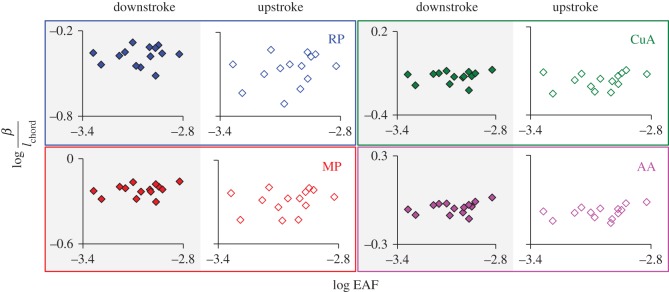
Logarithmic relationship between chord-length-specific deflection (β/lchord) at the trailing edge and the estimation of aerodynamic force (EAF). Colours and landmark names are as in figure 1a. None of the relationships were statistically significant; see electronic supplementary material, S10 for elaborated statistics.